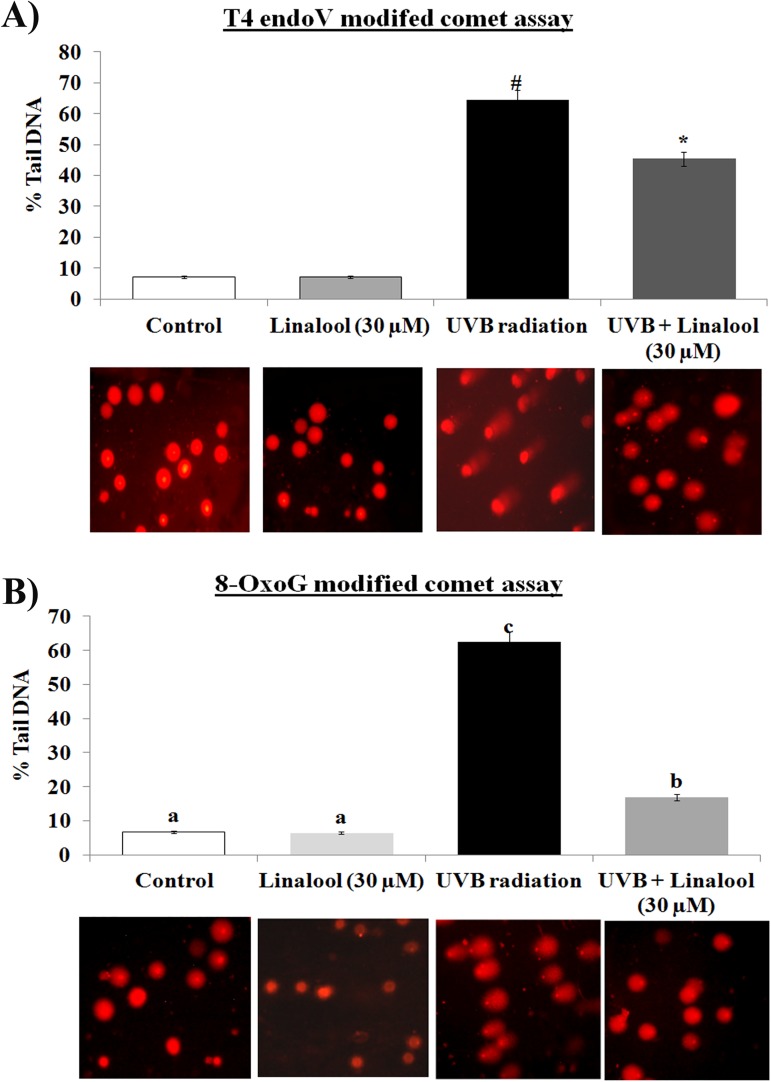
Effect of linalool on UVB induced DNA damage in HDFa cells.(A) Linalool on UVB induced CPDs formation was analyzed by T4 modified comet assay. Fluorescence microscopic images (20X) were recorded using fluorescence microscope (Cell imaging station, life technologies) under red fluorescence lamb. (B) Linalool on UVB induced 8-OxoG was analyzed by 8-OxoG modified comet assay. Fluorescence microscopic images (20X) were recorded using fluoresece microscope (Cell imaging station, life technologies) under red fluorescence lamb. The percentage tail DNA was calculated by CASP software for both CPD and 8-OxoG modified assay. Values are given as means ± SD of six experiments in each group. Values not sharing a common marking (# and *) differ significantly at P = 0.05 (DMRT).